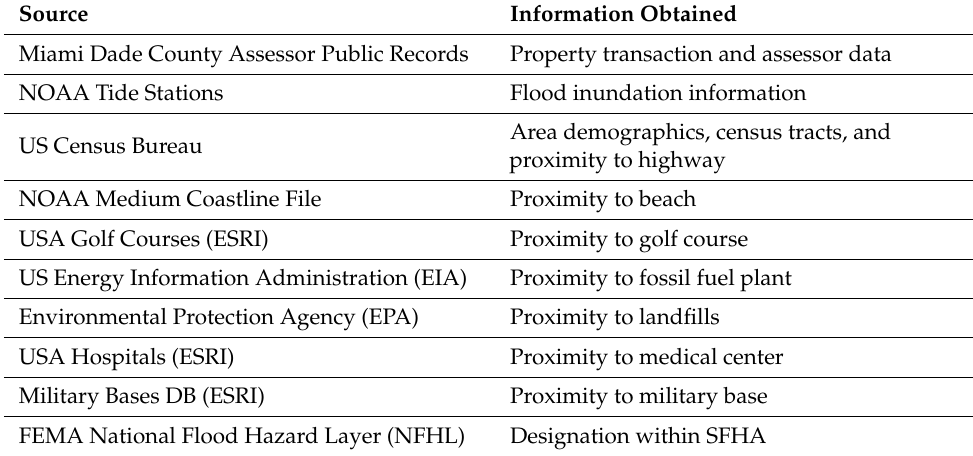
Table 2. Variable Data